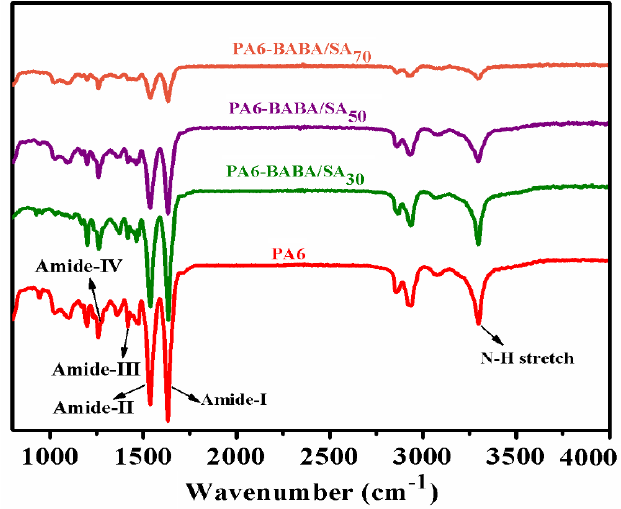
Figure 2. FTIR spectra of virgin PA6 and PA6-BABA/SA with various wt % of BABA/SA.